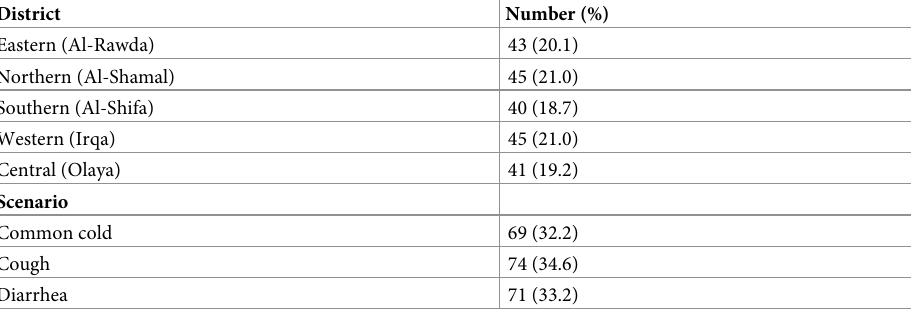
Table 2. Percentages of pharmacies visited in each district of Riyadh City and the frequency of the three